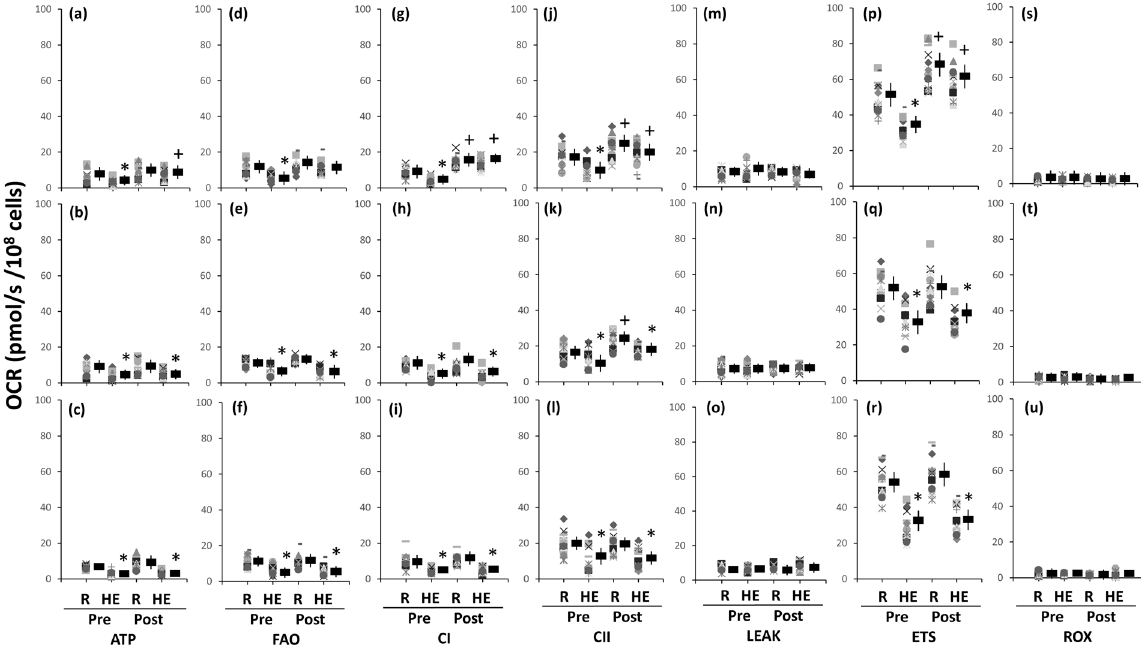
Figure 5. Effects of interval and continuous exercise regimens on mitochondrial O 2 consumption rate (OCR) in the permeabilized platelets. HIT (a , d , g , j , m , p , s) , high-intensity interval training group; MCT (b , e , h , k , n , q , t) , moderate-intensity continuous training; CTL (c , f , i , l , o , r , u) , control group; Pre , pre-intervention; Post , post- intervention; R , resting; HE , hypoxic (12%O 2 ) exercise test; ATP , ATP-linked OCR; FAO , fatty acid oxidation; ETS , electron transport system; CI , Complex I respiration; CII , Complex I respiration; ROX , Residual O 2 consumption. * P < 0.05, Rt vs. HE ; + P < 0.05, Pre vs. Post . Values were mean ±